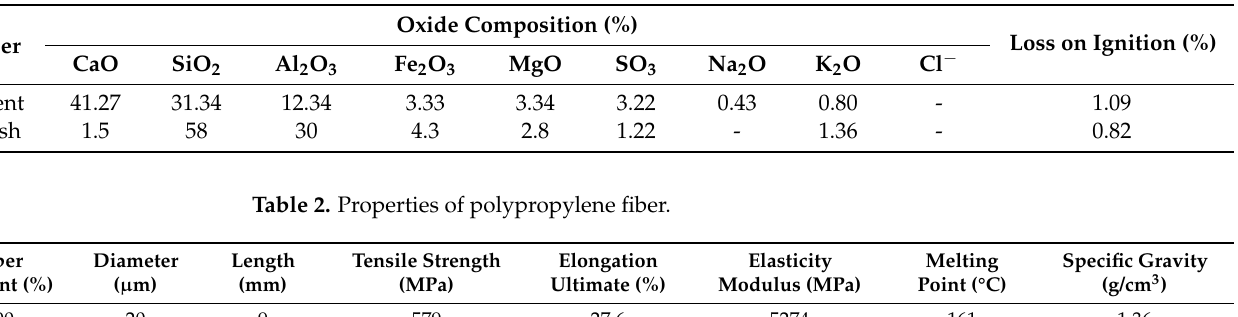
Table 1. The chemical composition and loss on ignition of the binding materials.